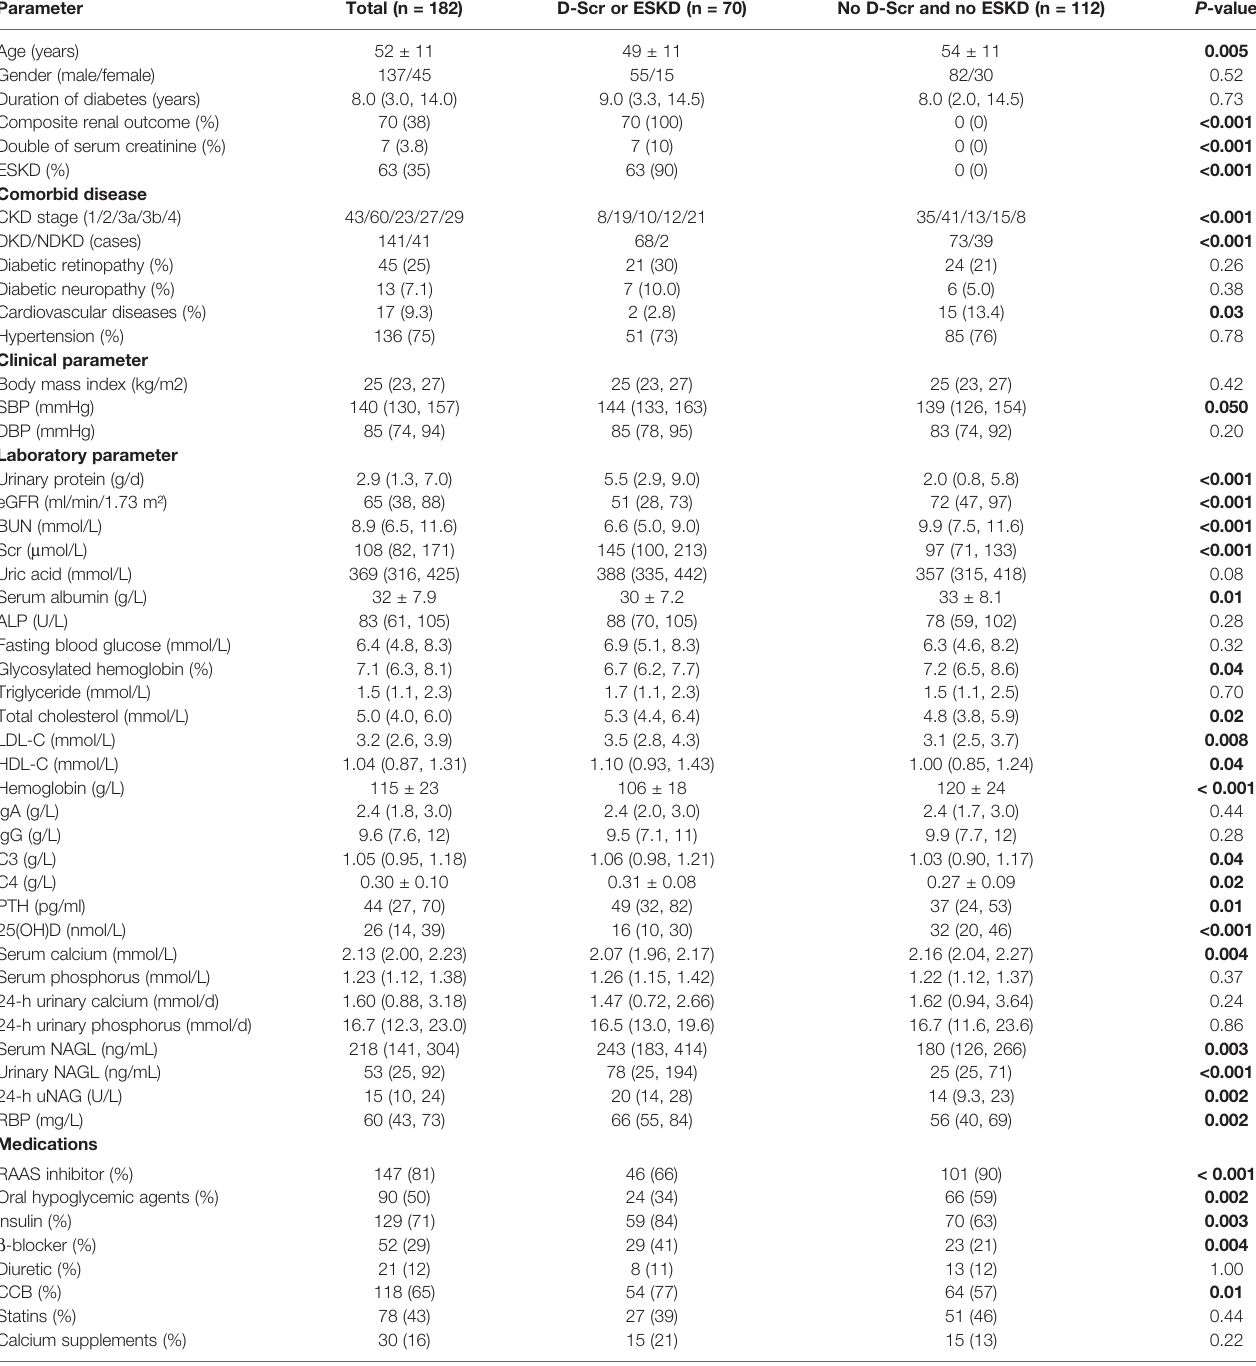
TABLE 1 | Baseline characteristics and laboratory data for all enrolled